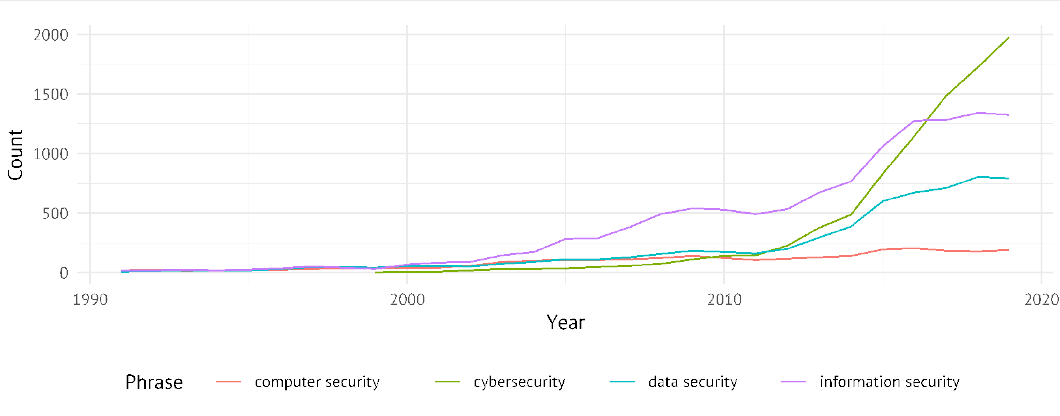
FIGURE 1: Academic articles with cybersecurity / cyber-security / cyber security versus information security , data security and computer security in title, keywords or abstract of Web of Science indexed publications over time. Small numbers of records exist for both information security and computer security in the database since 1969. Data from Web of